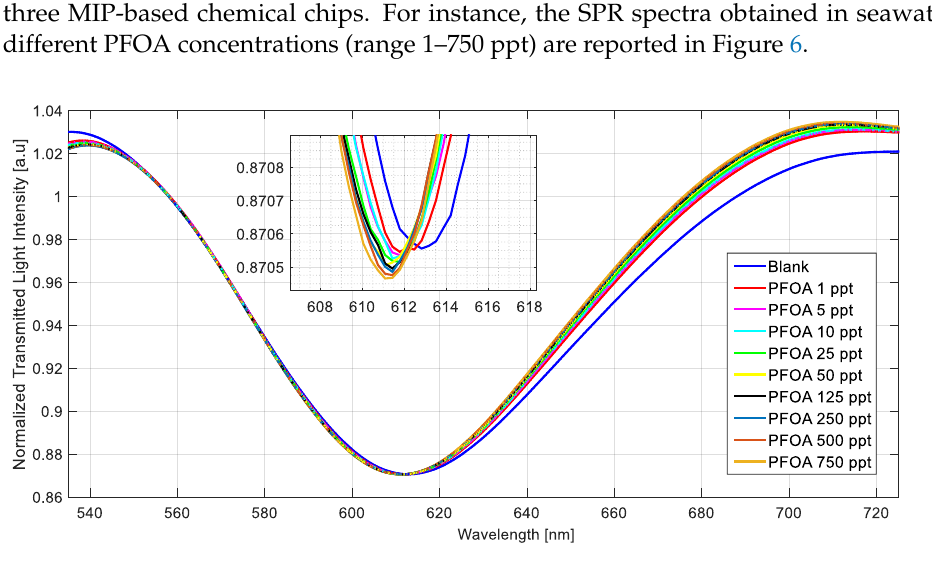
Figure 6. Normalized transmitted spectra obtained by fixing the refractive index (1.332) on the SPR – POF chip and increasing the PFOA concentration (range 1 – 750 ppt) in seawater on the MIP-based chemical chip.